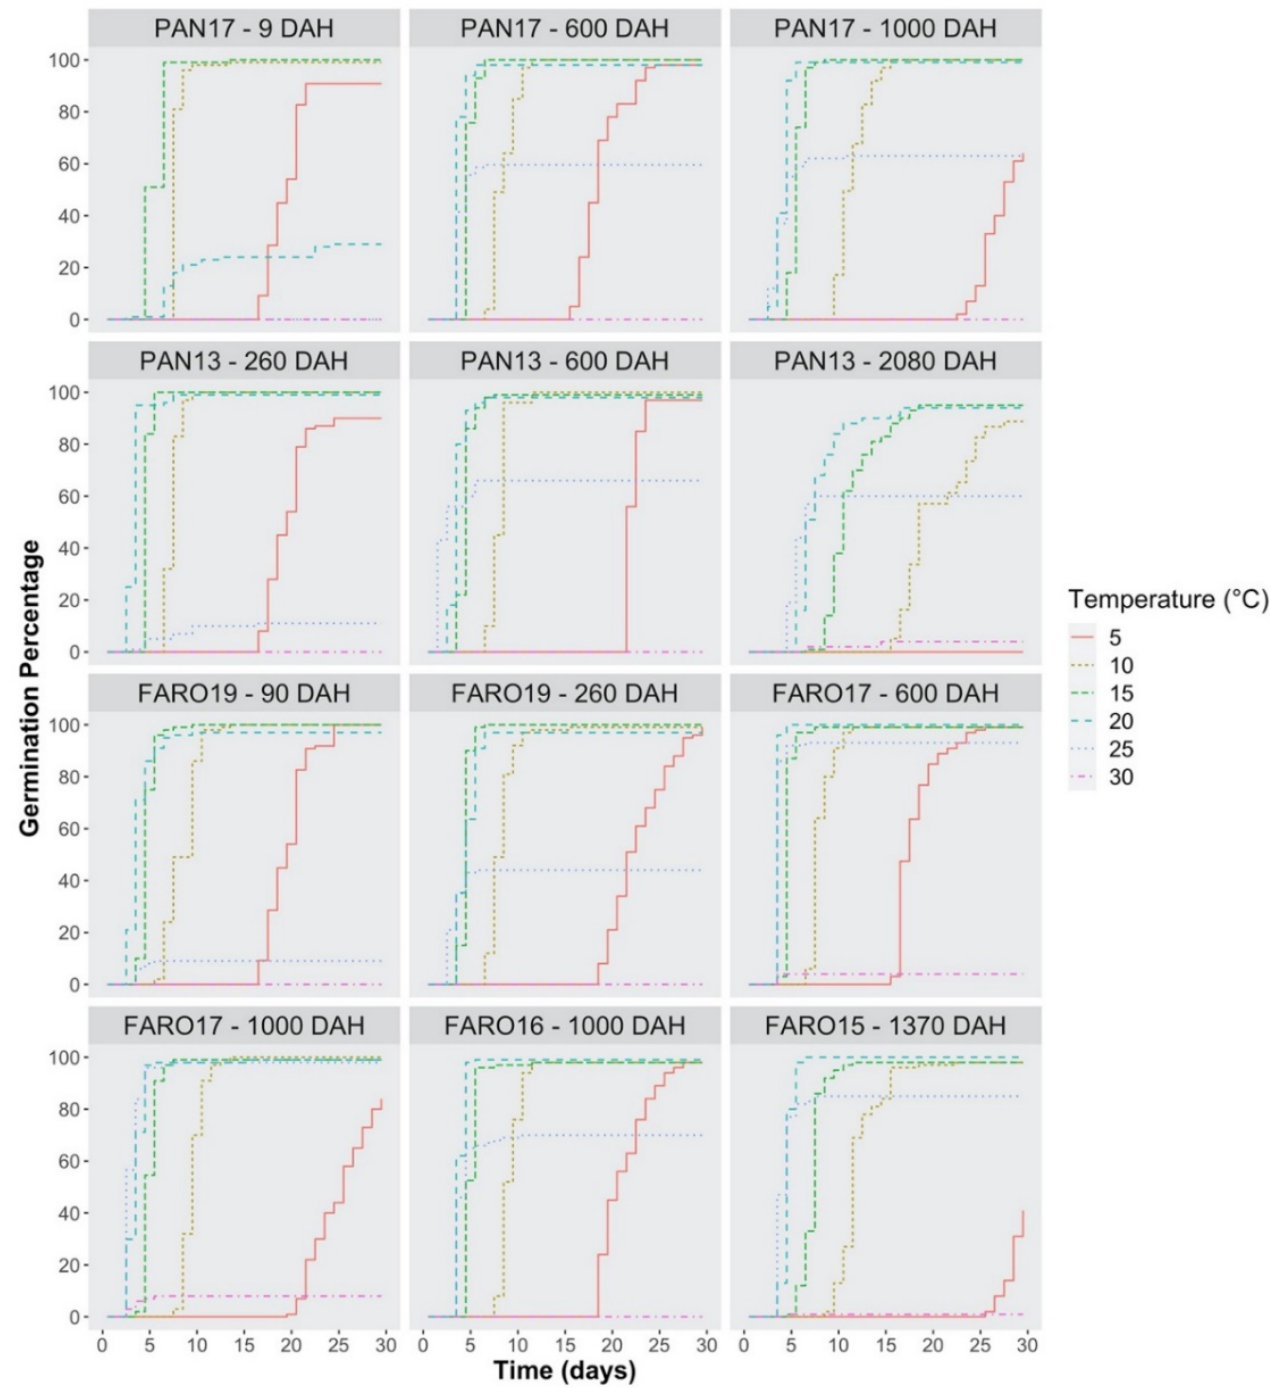
Figure 4. Kaplan–Meier estimates of germination curves for seeds of two S. hicesiae seed sources (PAN and FARO) at seven different seed ages (9, 90, 260, 600, 1000, 1370, and 2080 days after harvest = DAH), incubated for 30 days under light/dark conditions (L/D), at six constant temperatures regimes (from 5 °C to 30 °C), and expressed as the percentage of viable seeds.